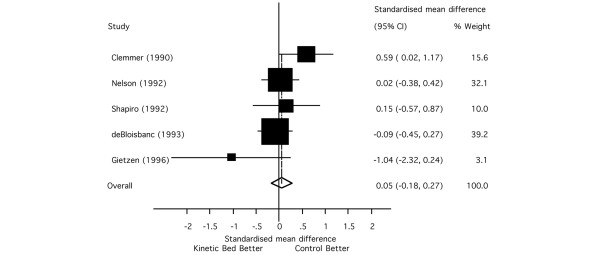
Forest plot showing the effect of kinetic bed therapy on hospital length of stay. CI, confidence interval.